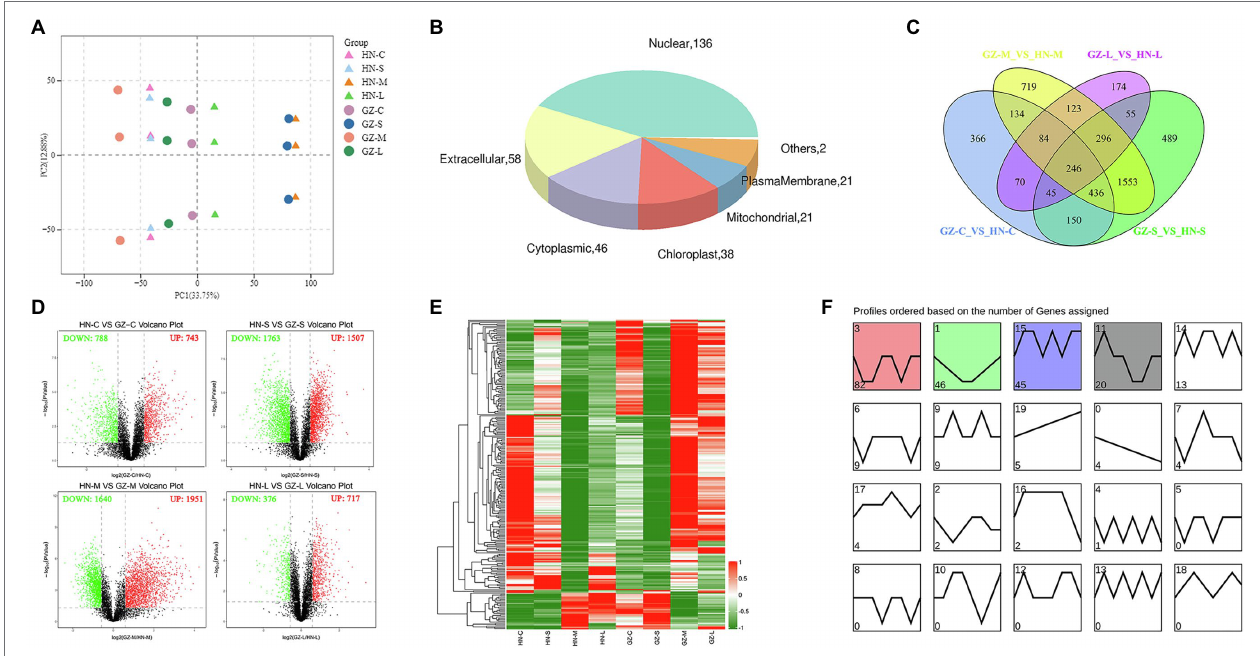
FIGURE 5 | Proteome differences between GZ and HN under salt treatments. (A) Principal component analysis (PCA) analysis. (B) Subcellular localization analysis of the common DEPs. (C) Venn diagram of the DEPs. (D) Volcano plot analysis on the DEPs. Protein accumulation are represented by red spots (up-regulated), green spots (down-regulated). (E) The heatmap of the common DEPs. (F) Trend analysis shows of the common